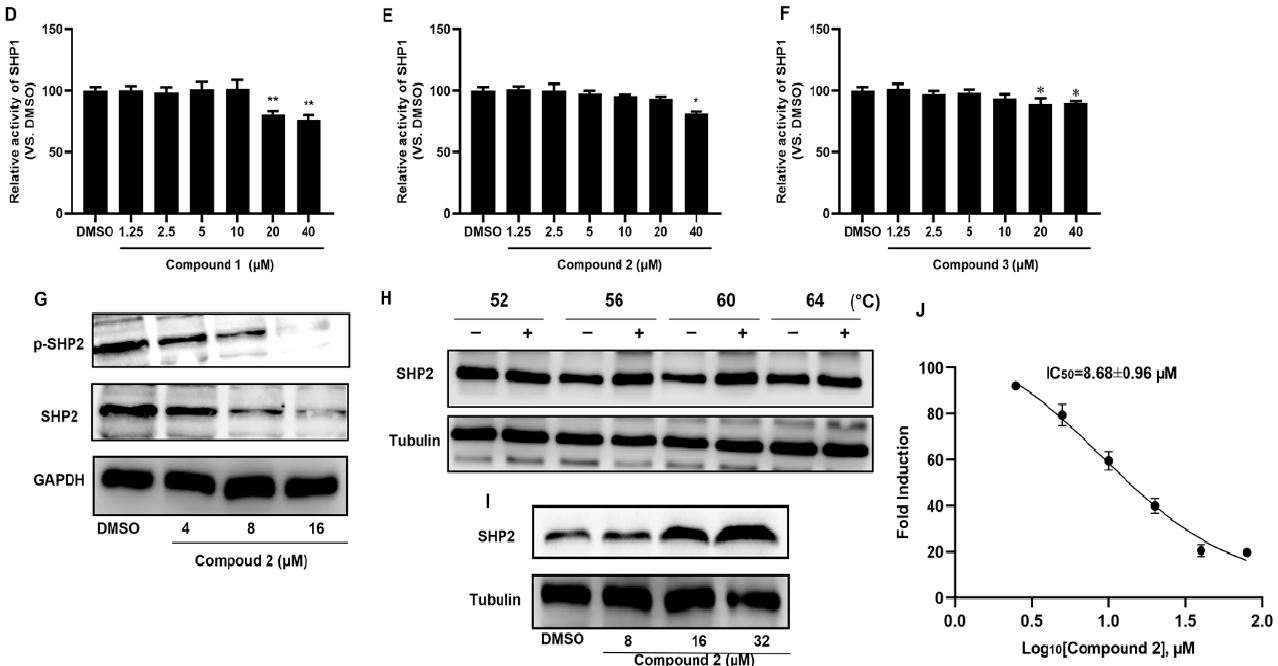
Figure 2. The inhibitory effects of compounds 1 – 3 on SHP1 and SHP2. The IC 50 of compounds 1 – 3 ( A – C ) on SHP2. The inhibitory effects of compounds 1 – 3 ( D – F ) on SHP1. ( G ) The effects of compound 2 on cellular SHP2 expression. ( H , I ) Cellular thermal shift assay between SHP2 and compound 2 . ( J ) The cytotoxicity of compound 2 in A549 cells. Cont., DMSO control. (*) p < 0.05, (**) p < 0.01 compared with the control group.